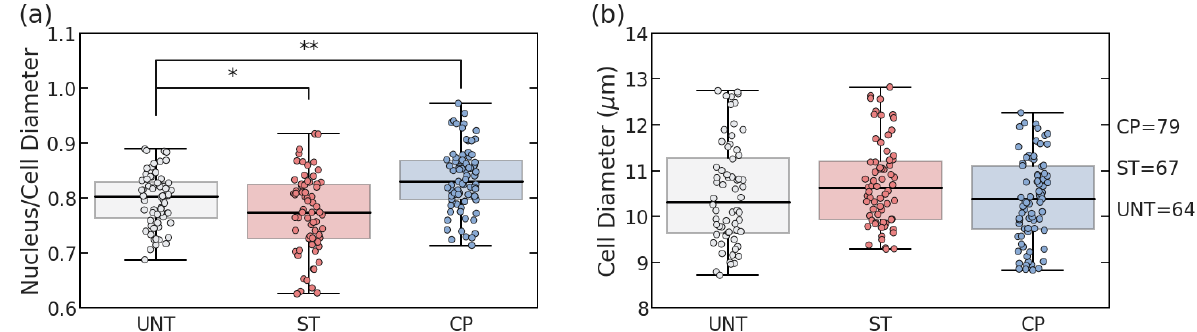
Figure 1. Experimental structure overview demonstrating both data collection and application of the ML paradigm of dual normalization, feature selection, and classification.